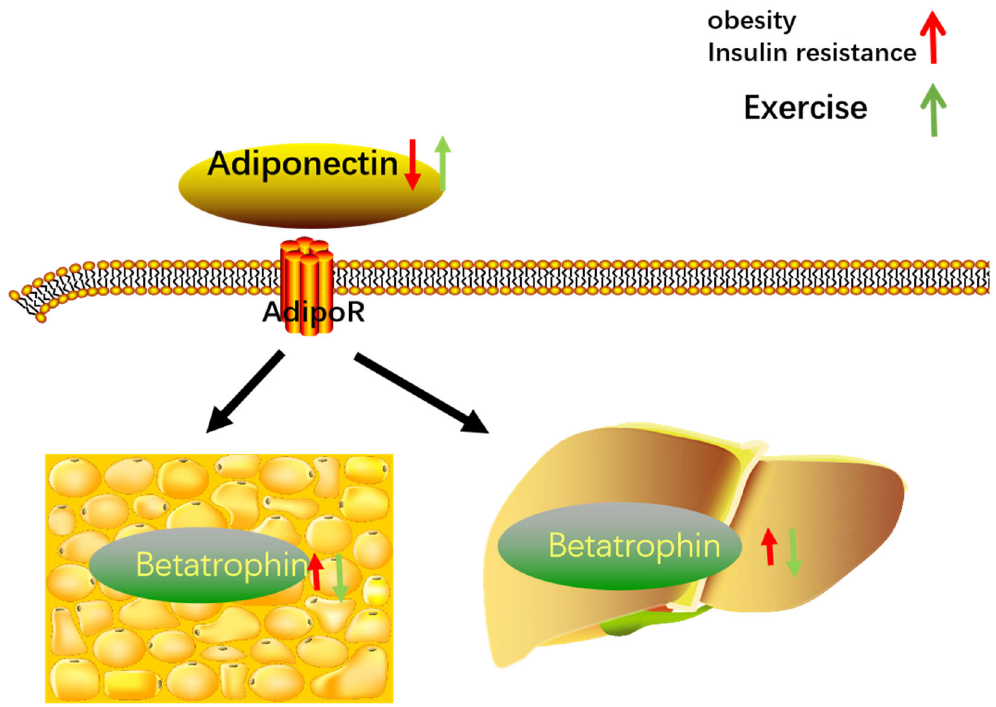
Figure 1. The relationship between Adiponectin and Betatrophin,and their response to exercise and IR.